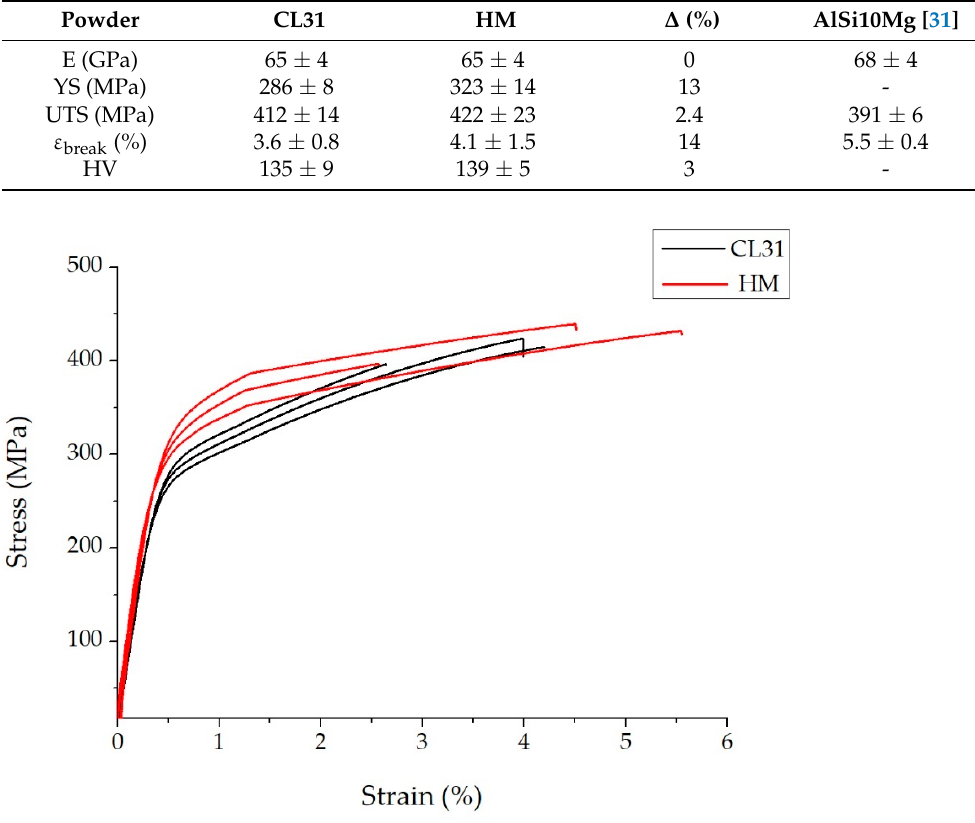
Figure 6. Representative stress strain curves of the CL31 and HM samples.